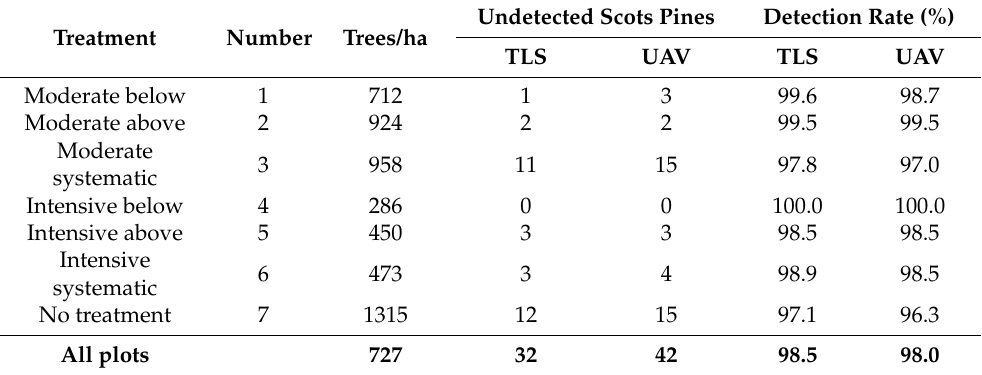
Table 5. Tree density, including all tree species, number of undetected Scots pine trees by terrestrial laser scanning (TLS) and unmanned aerial vehicle (UAV), and detection rates within different thinning treatments.